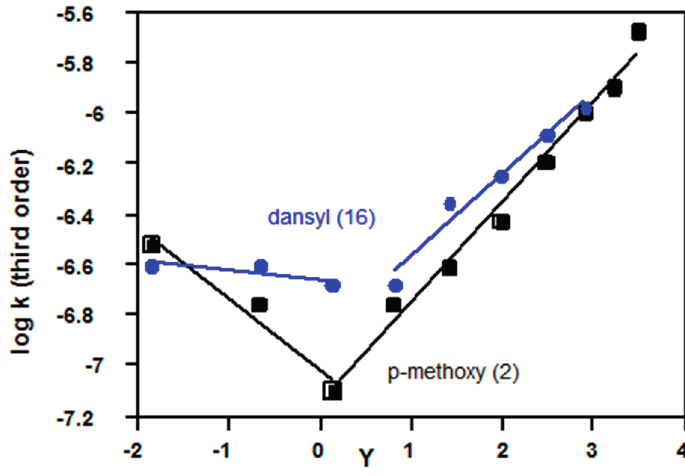
Figure 10. Plots of log k 3 vs. Y (Equation (3)) for solvolyses in acetone-water of 4-methoxybenzene sulfonyl ( 2 , Z = OMe) at 25 °C, and dansyl chlorides ( 16 ) at 35 °C; data from References [79,81,82].